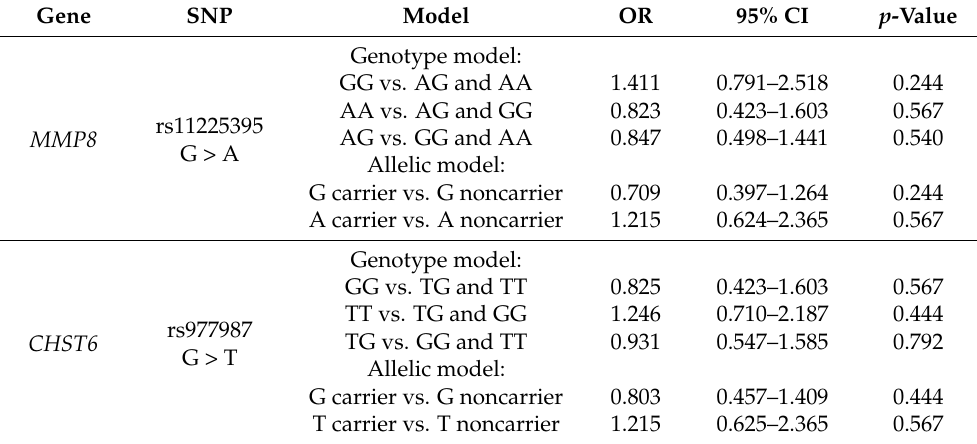
Table 3. Association between MMP8 , CHST6 , and MMP14 polymorphisms in allele and genotype models and Dupuytren’s contracture